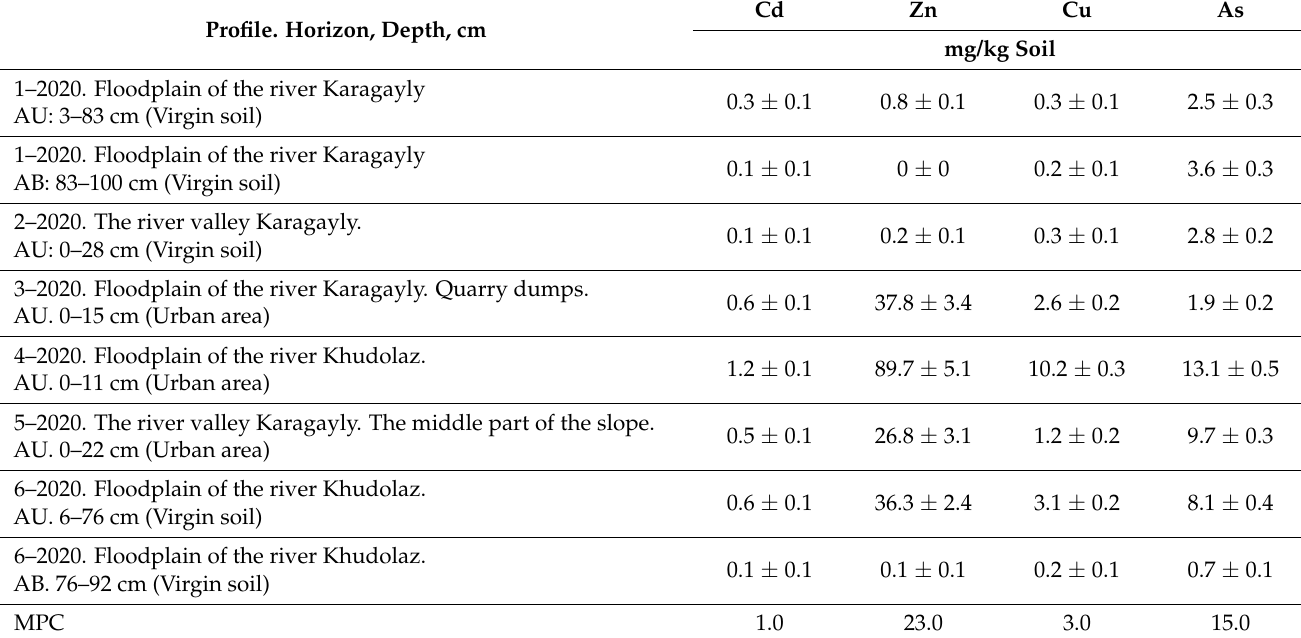
Table 4. The content of labile forms of heavy metals and arsenic in the soils. Values ± SE ( n = 3). Cd Zn Cu As Profile. Horizon, Depth, cm mg/kg